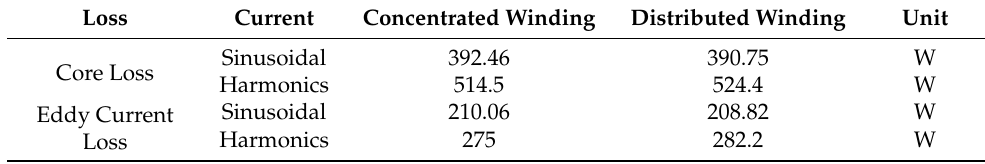
Table 3. Comparison of electromagnetic losses obtained using FEM